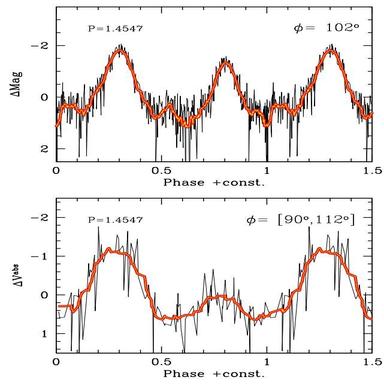
Same as but for two datasets taken at orbital phase angles larger than 90, namely the data taken at Great Shefford Obs. (upper panel) and the DeSS data (TRACKER telescope; lower panel). Compared to the previous figure, a substantial change in the lightcurve shape is evident, with an intervening secondary maximum that keeps growing midway of the curve. This transient feature (that only appeared in the very last minutes before the atmosphere entry of WT1190F) is striking in the Grea